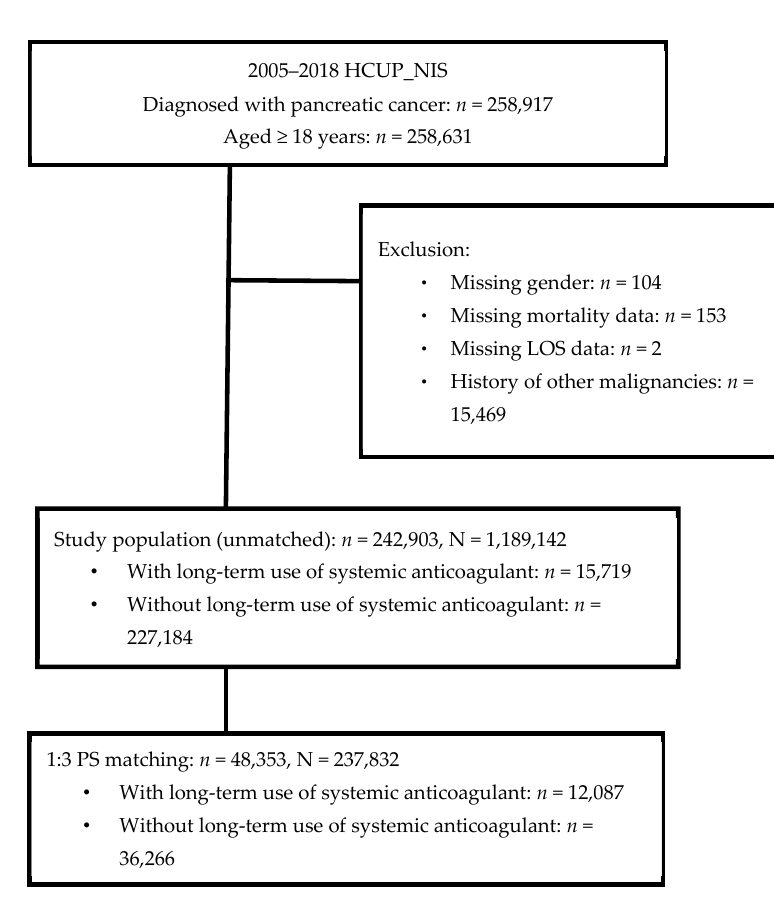
Figure 1. Flow diagram of study selection.